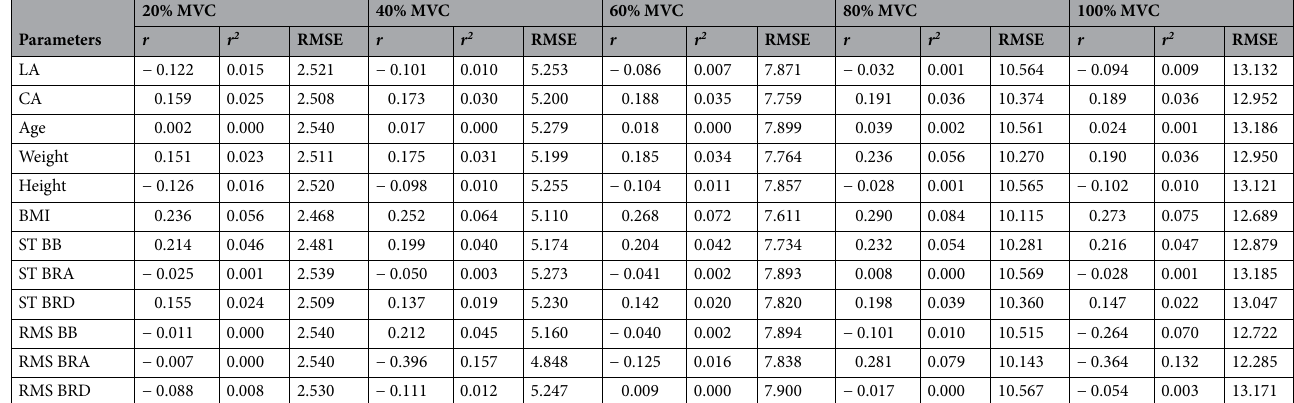
Table 4. Bivariate analysis of torque against anthropometrics and MMG RMS during supination task. *Bold font indicates significant